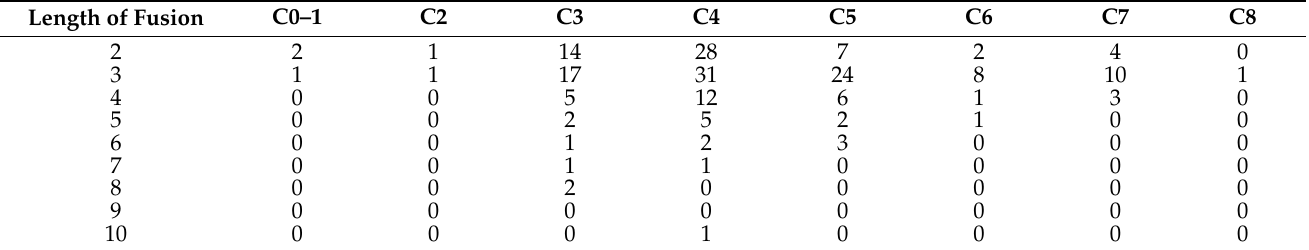
Table 2. Length of fusion and frequency of the neurological level of injury.